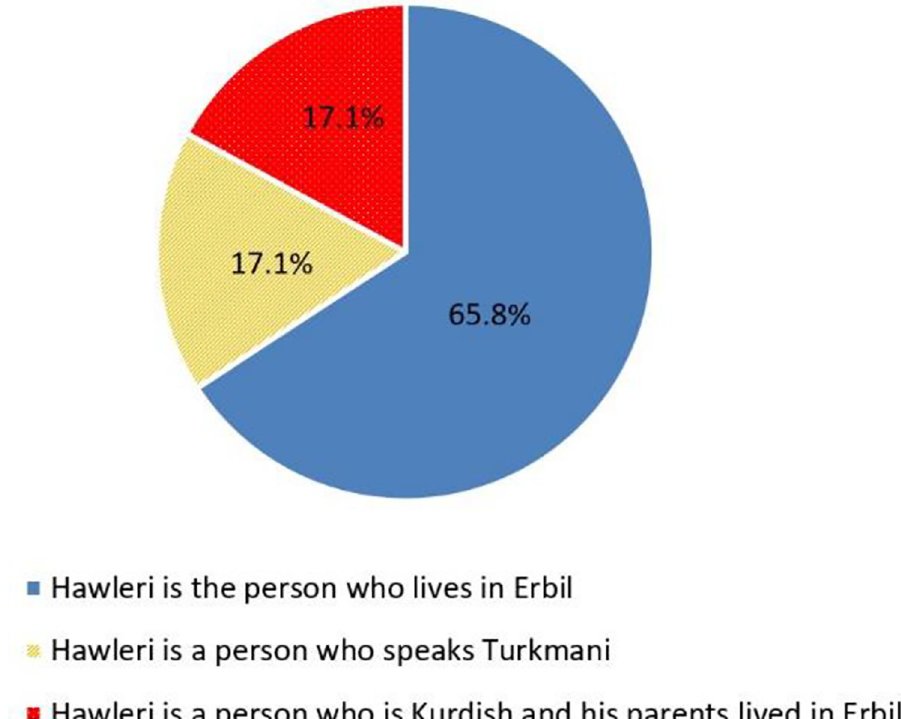
Fig 3. The feedbacks of the social media group (#lo)